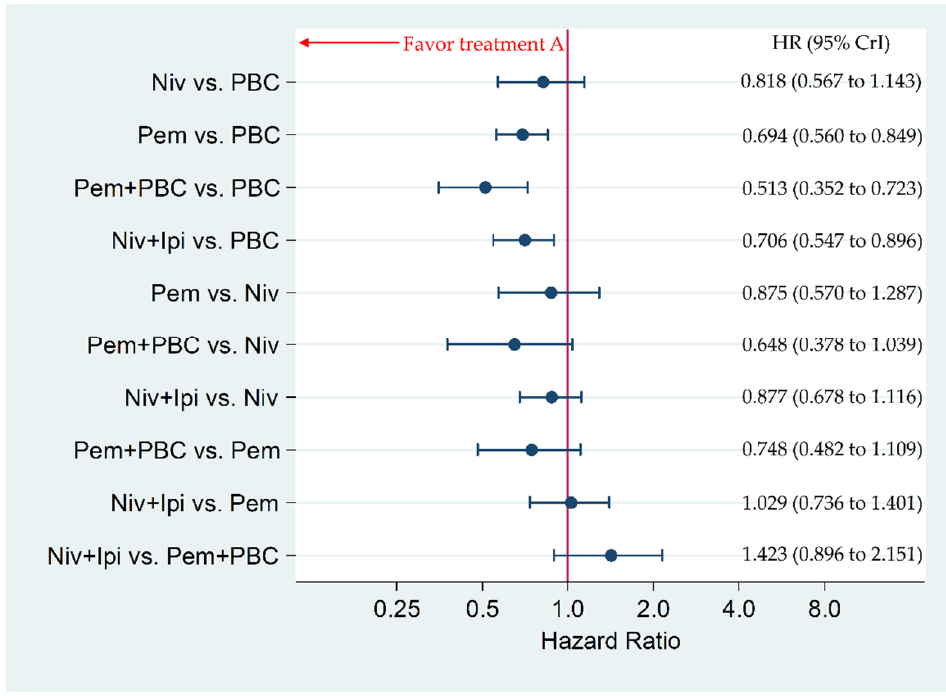
Figure 6. Comparative efficacy for overall survival (OS) among the five therapeutic regimens (Niv+Ipi, Pem+PBC, Pem, Niv, and PBC) in patients with programmed cell death ligand 1 (PD-L1) expression levels of 50% or more. Comparisons were expressed as Treatment A versus Treatment B. Data are expressed in terms of hazard ratio (HR) and 95% credible intervals (CrIs); Niv, nivolumab; PBC, platinum-based chemotherapy; Pem, pembrolizumab; Ipi, ipilimumab.